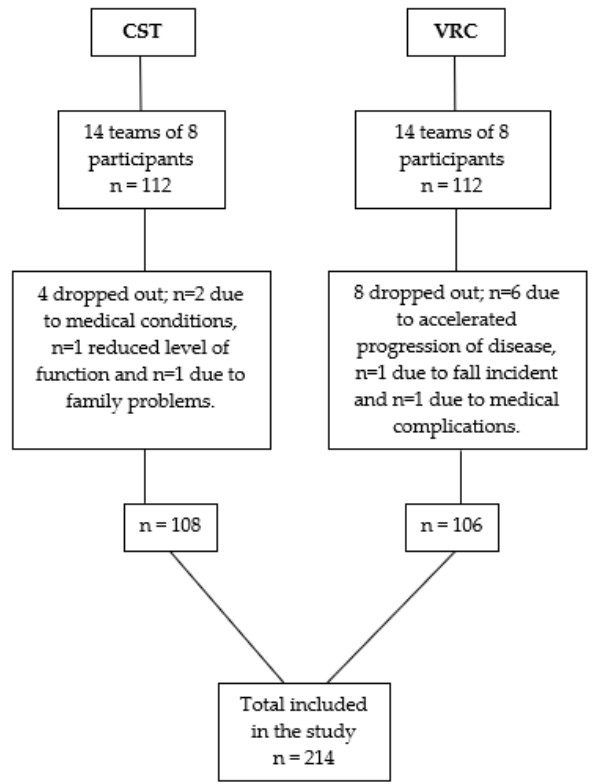
Figure 2. Flowchart of included participants. CST: Center of Health and Rehabilitation, Danish Association for Rheumatism Skaelskoer. VRC: Vejlefjord Rehabilitation Center N: number.